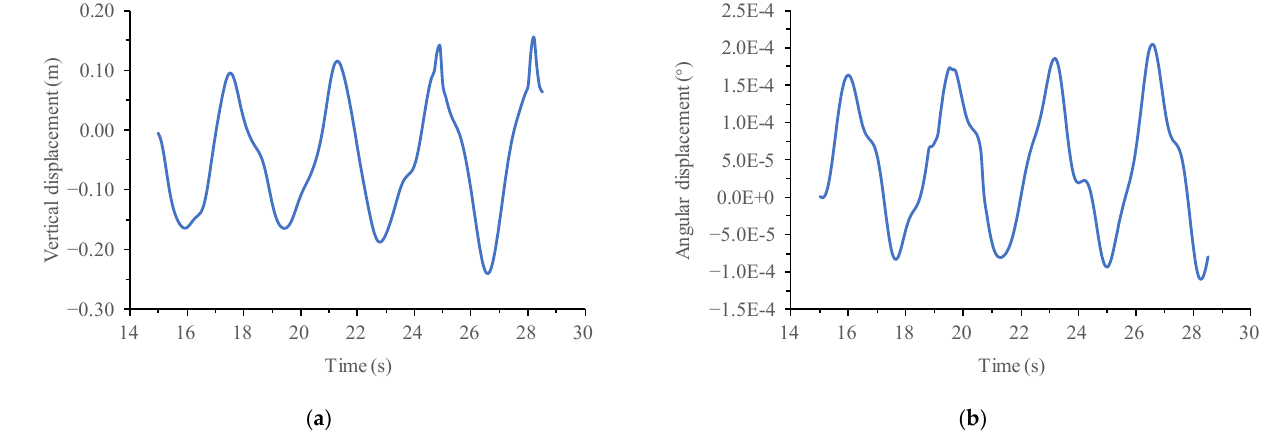
Figure 12. Time-history curve of mid-span displacement of Xiangshan Harbor Bridge when wind speed was 75 m/s. ( a ) Vertical displacement; ( b ) Angular displacement.